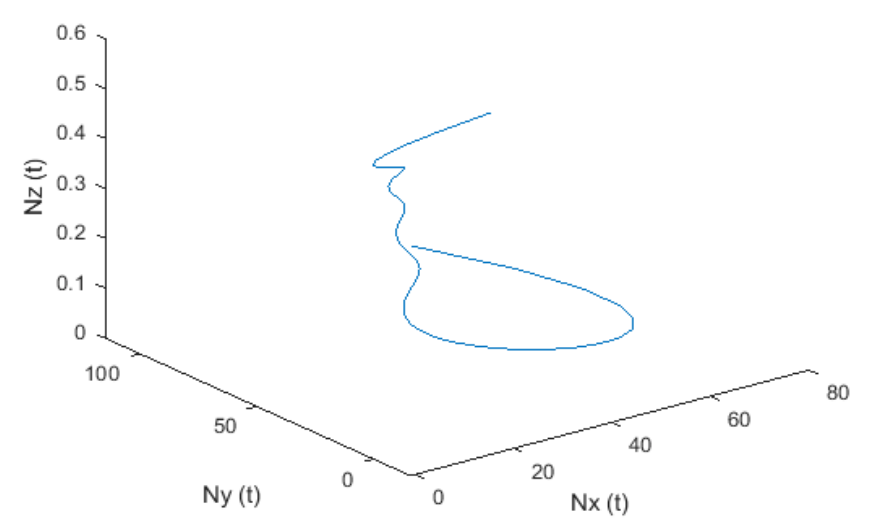
Figure 7. Numerical solutions of the Bloch equation with parameters: α = β = γ = 0.7, w 0 = 12, T 1 = 1, T 2 = 20, a = 1, b = 1.